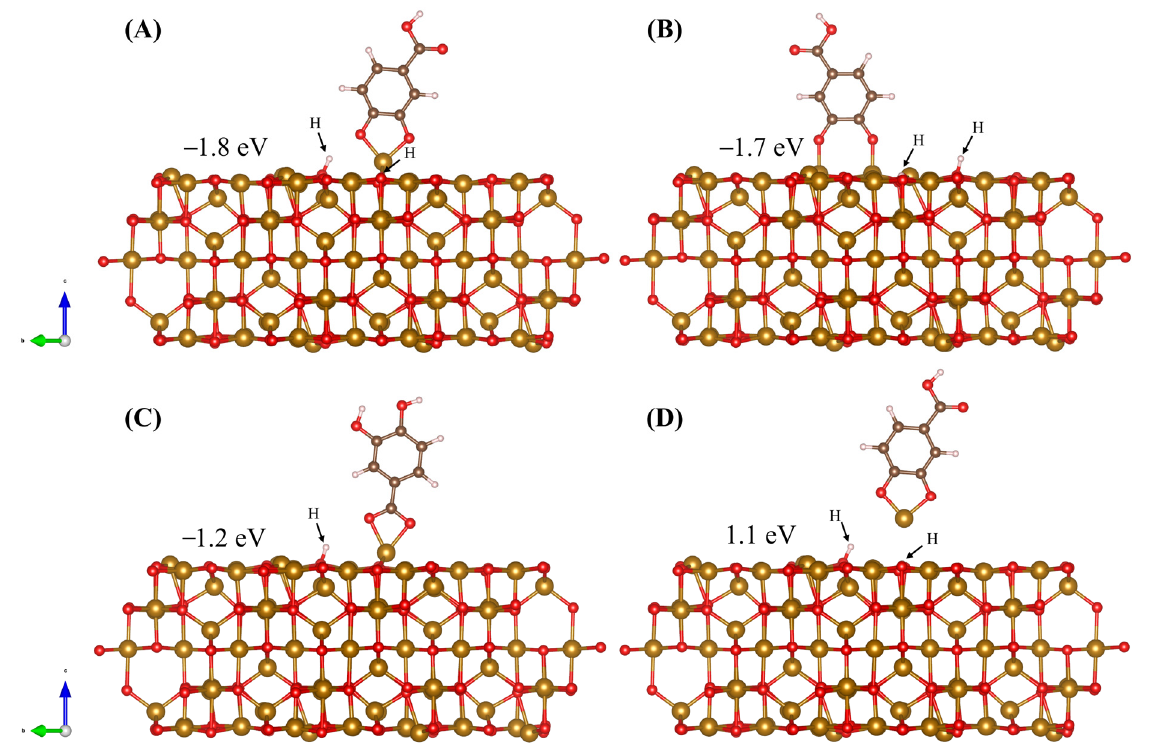
Figure 8. Adsorption of DHBA on the (001) surface of Fe 3 O 4 in three different configurations, ( A ) chelating bidentate via phenolic OH groups, ( B ) bridging bidentate via phenolic OH groups, ( C ) chelating bidentate via carboxyl group, and ( D ) scenario where molecule adsorbs and detaches with Fe atom. The adsorption is accompanied by the surface adsorption of H + ions displaced from OH groups. Values on each panel represent respective adsorption energies.